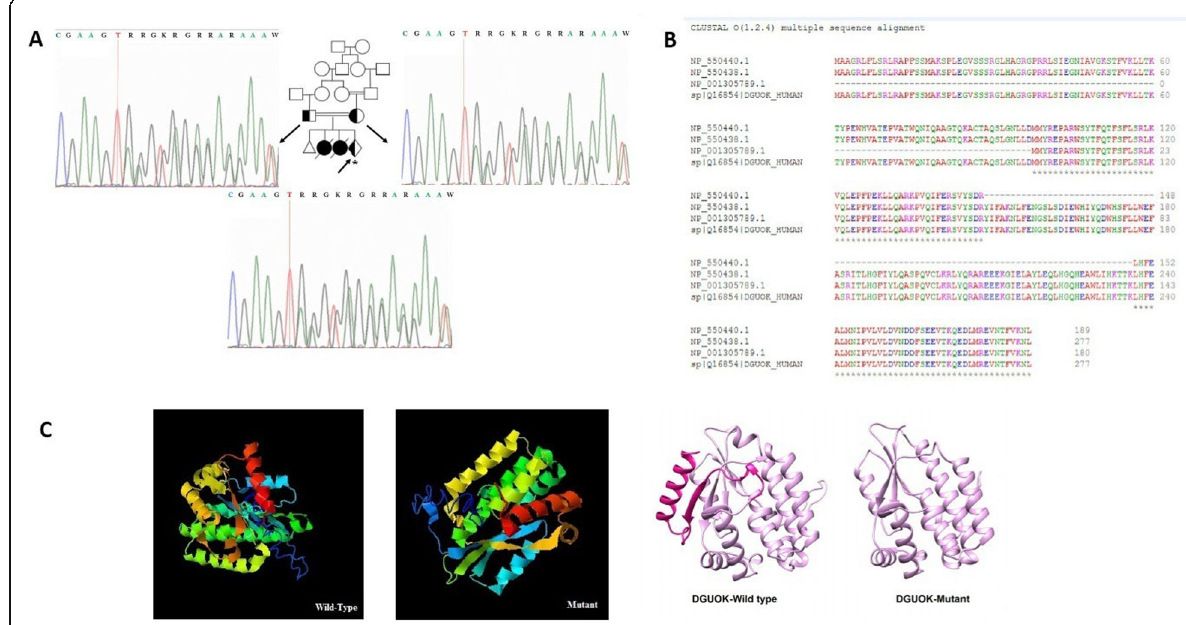
Fig. 1 a Family I pedigree and sequence chromatograms. Both parents are heterozygous for the frameshift deletion mutation in DGUOK gene. The current pregnancy was a heterozygous carrier of the mutation. The proband is marked by an asterisk. b Clustal Omega multiple sequence alignment of all functional human encoding isoforms of DGUOK protein showing that all functional isoforms share the same amino acid sequence after codon 236. c Three dimensional structure of DGUOK wild type and mutant proteins were predicted by I-TASSER server. UCSF chimera was used to compare the structures. The deleted region is displayed in